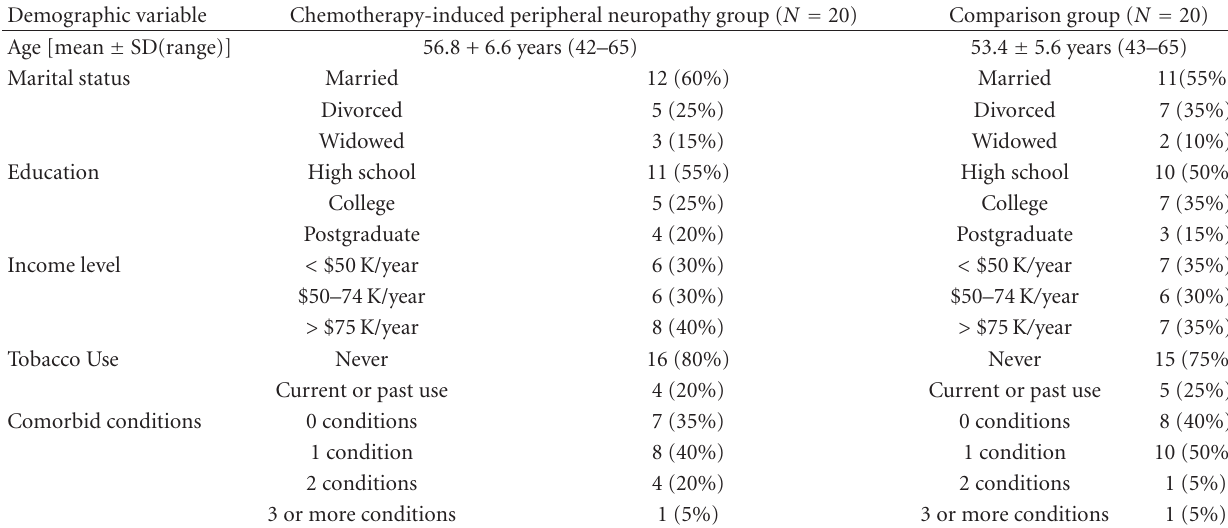
Table 1: Sample Characteristics.